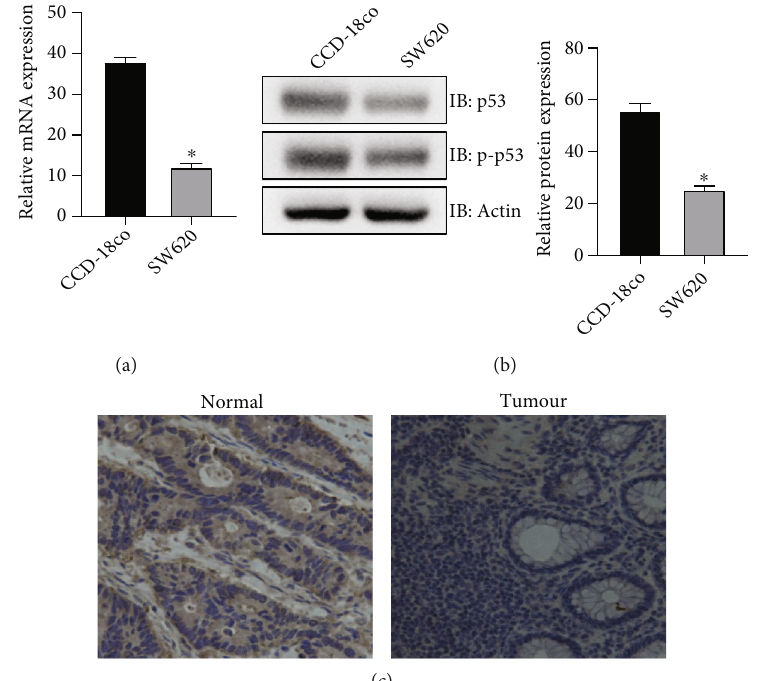
Figure 1: Low expression of p53 in colon cancer tissues and cells. (a) p53 expression was low in colon cancer cells by QRT-PCR. (b) Low expression of p53 in colon cancer cells by western blot. (c) Low expression of p53 in colon cancer tissues. ∗ P < 0 : 15 , compare with the CCD- 18co